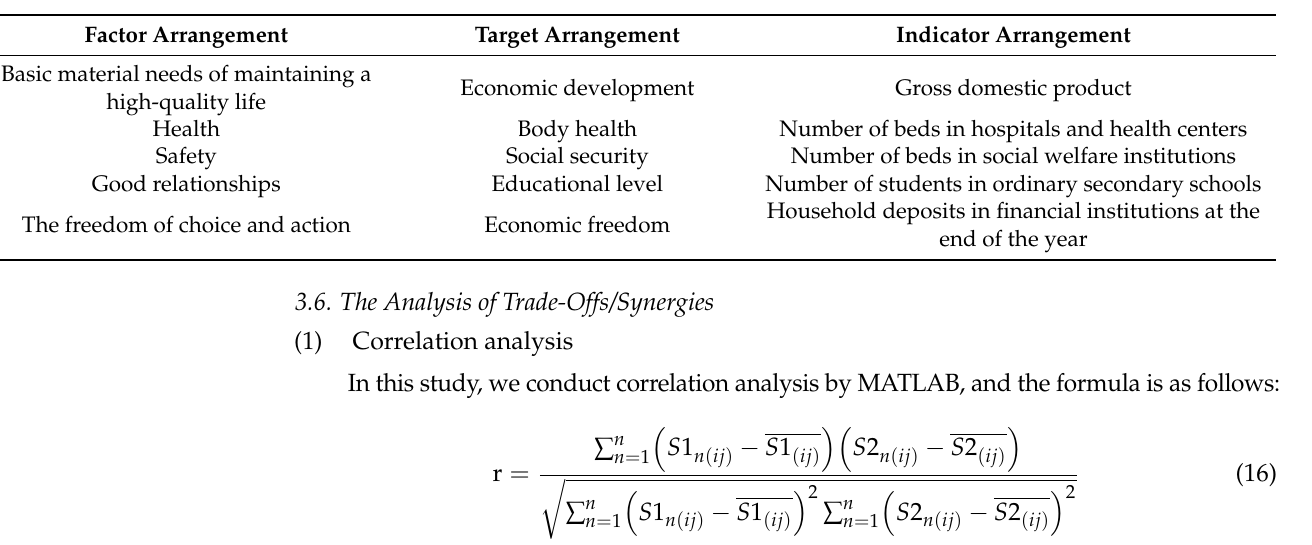
Table 3. The indicators system of evaluating